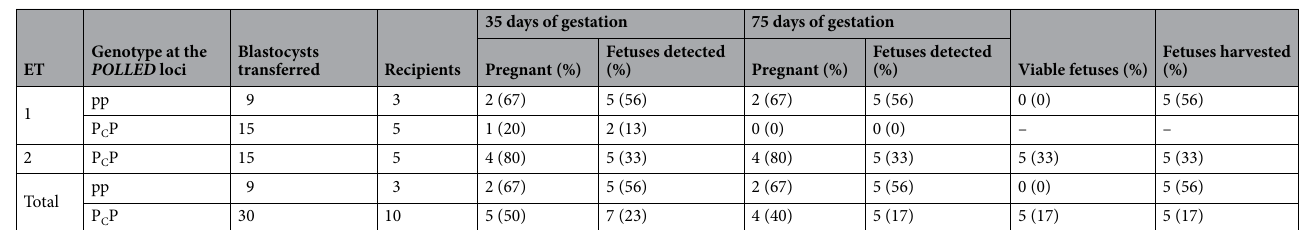
Table 1. Embryo transfer (ET) results from zygotes injected 6 h post insemination with Cas9 protein and gRNAs linc 5 ′ g1 and linc 3 ′ g1. Three blastocysts were transferred per recipient. Confirmation of pregnancies was performed on day 35 of gestation and fetal viability at 75 days of gestation. Nonviable fetuses were harvested immediately, and viable fetuses were harvested at 90 days of